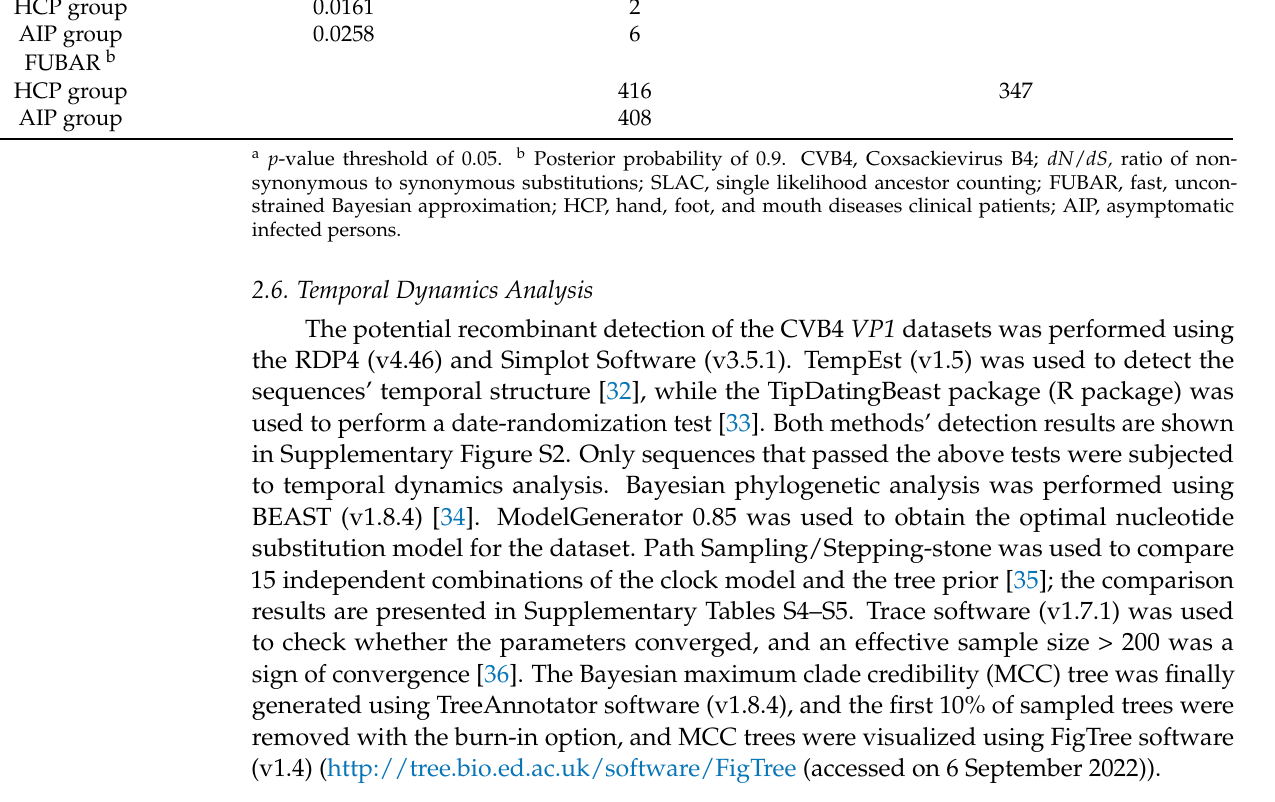
Table 1. Pressure selection analysis of the CVB4 P3 region isolated from healthy children and patients. No. of Negative/Purifying Position(s) of Positive/Diversifying Method of Analysis Mean dN / dS Selection Sites Selection Site and Dataset